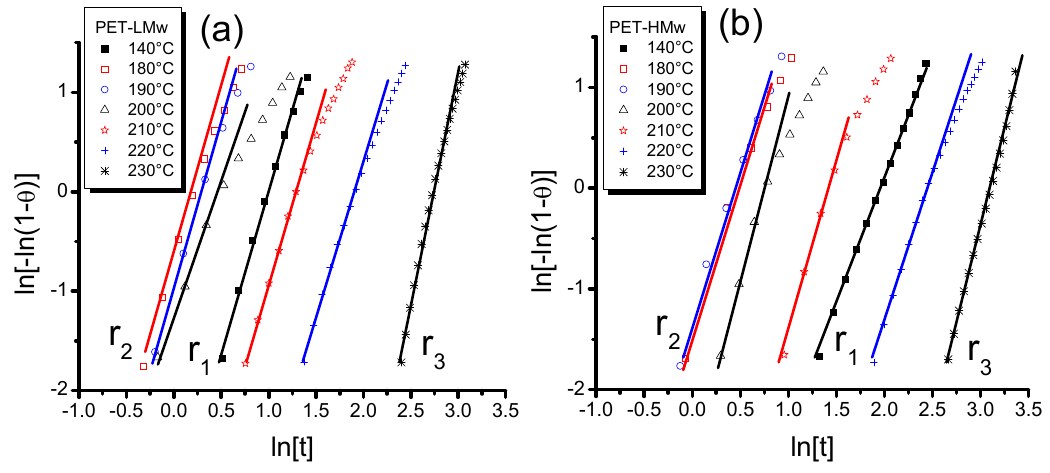
Figure 5. Avrami plots obtained from transmitted depolarized light intensity of different PET samples isothermally crystallized at different temperatures: ( a ) PET-LMw; and ( b ) PET-HMw.